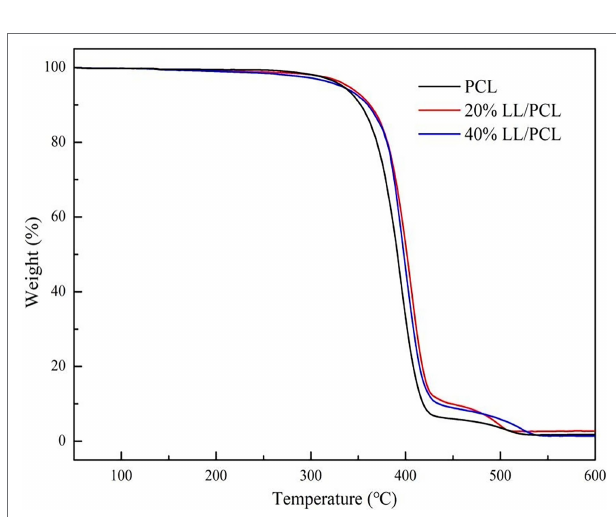
FIGURE 4 | Thermogravimetric curves of LL/PCL fibrous membranes.